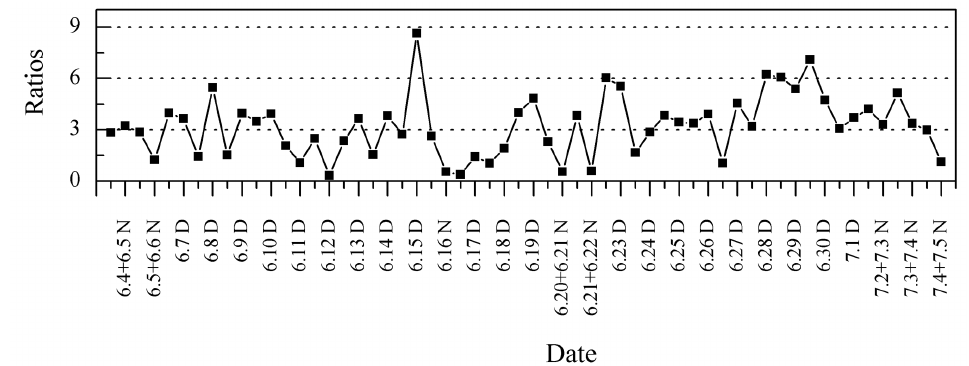
Figure 11. Time series of the Ph / C 9 ratios (D: day, N: